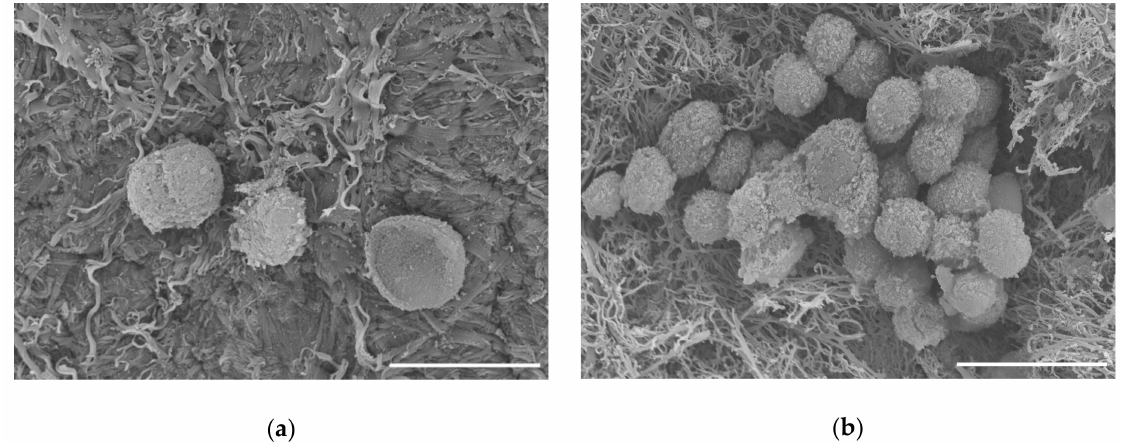
Figure 7. Scanning electron micrographs of C28/I2 chondrocyte cells on decellularized scaffold. ( a ) Cells attached to scaffold after 1 week in culture. ( b ) Cells on scaffold after 8 months in culture. Scale bar = 20 µ